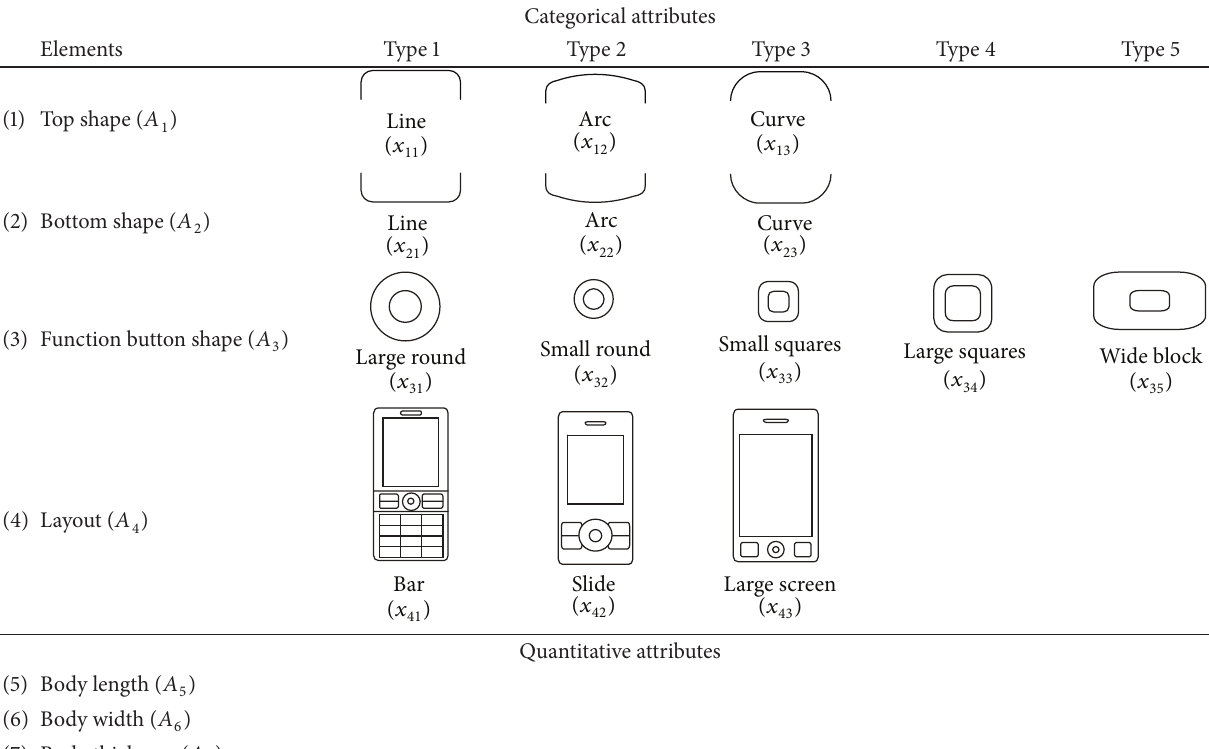
Table 1: Design table for the product form of the mobile